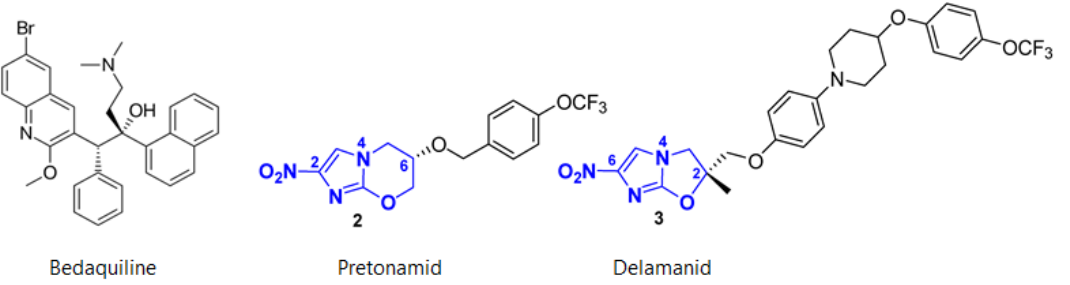
Figure 11. Bedaquiline, pretomanid, and dalamanid.